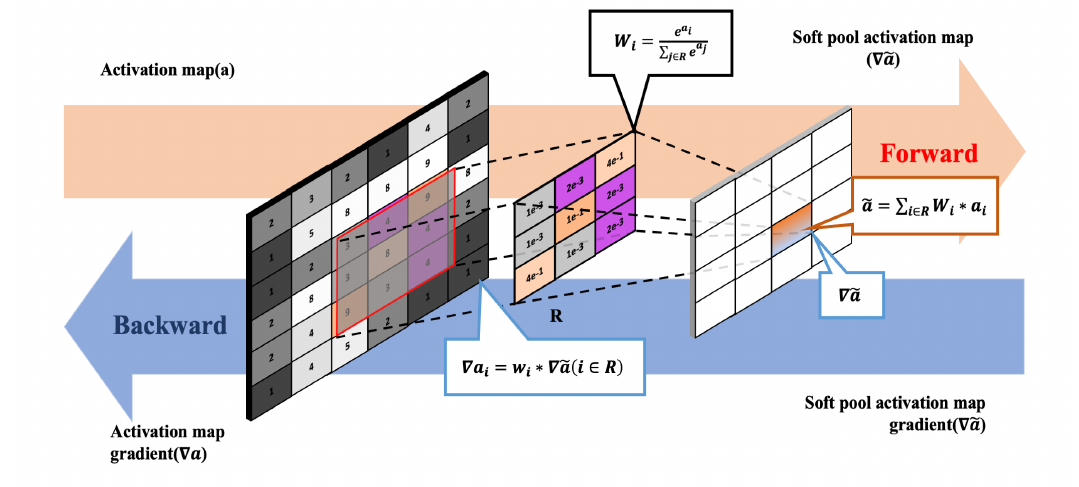
Figure 6. SoftPool